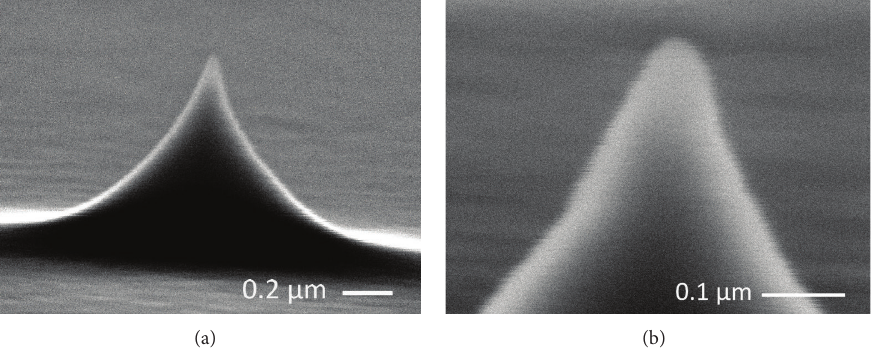
Figure 9: SEM images of emitters measured at the investigation: (a) with a height of 0: 9 𝜇 m and (b) with a radius of